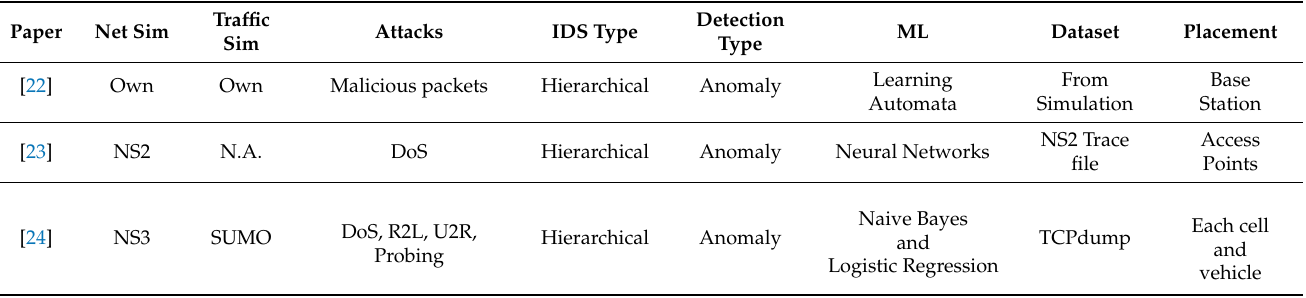
Table 1. Related Work—ML-Based IDSs for